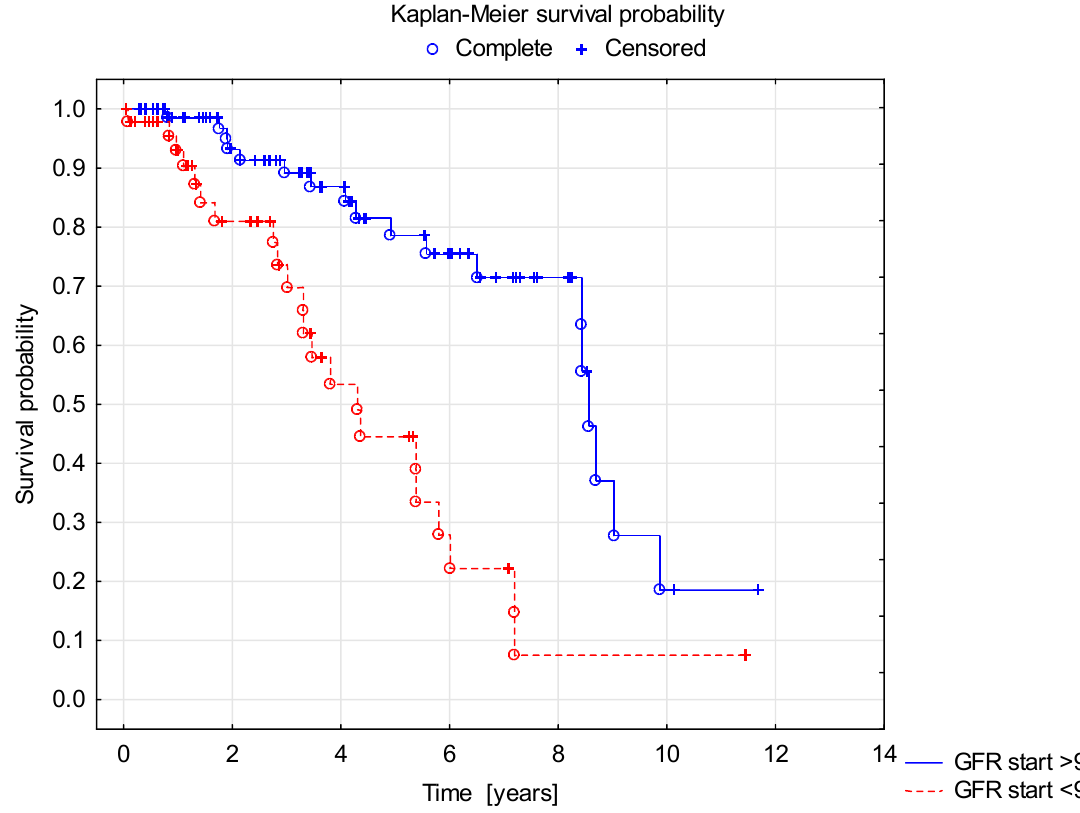
Figure 3. Shorter renal survival with normal GFR in males vs. females.